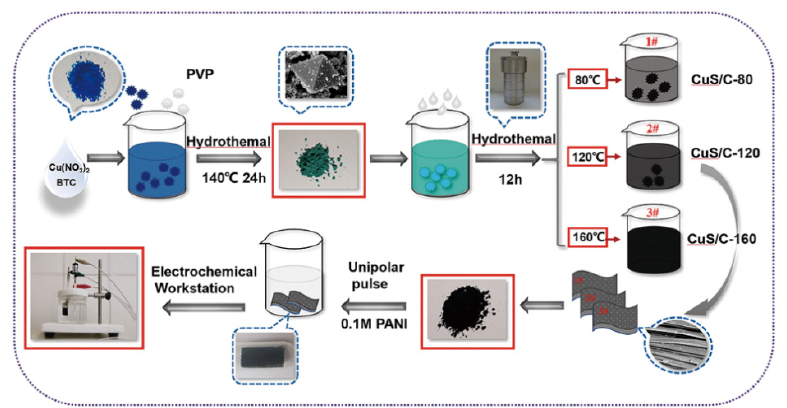
Figure 1. Schematic illustration of the fabrication of CuS/C ‐ 120@PANI nanocomposite.